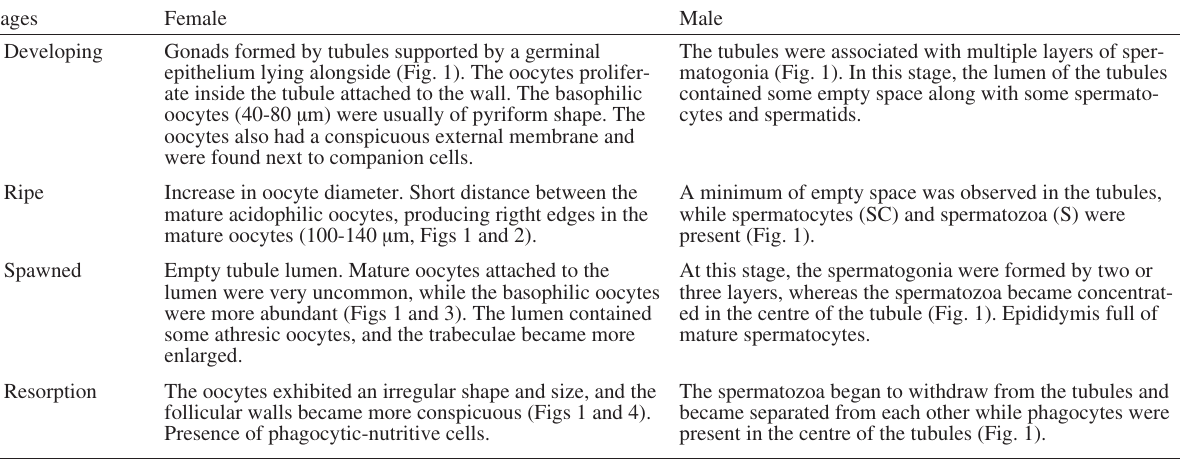
Table 2. – Stages of gametogenic cycle in males and